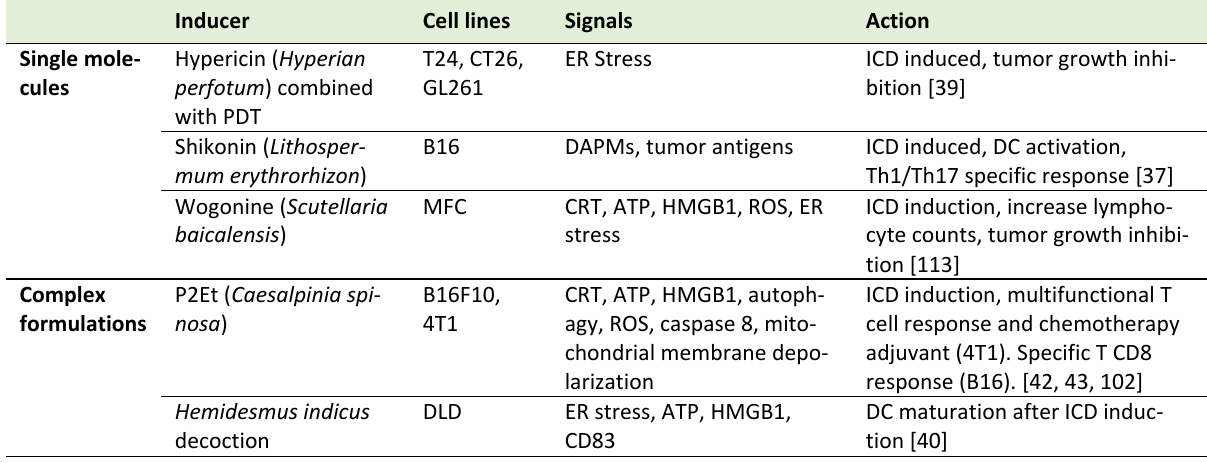
TABLE 2. Natural products reported as ICD inducers.